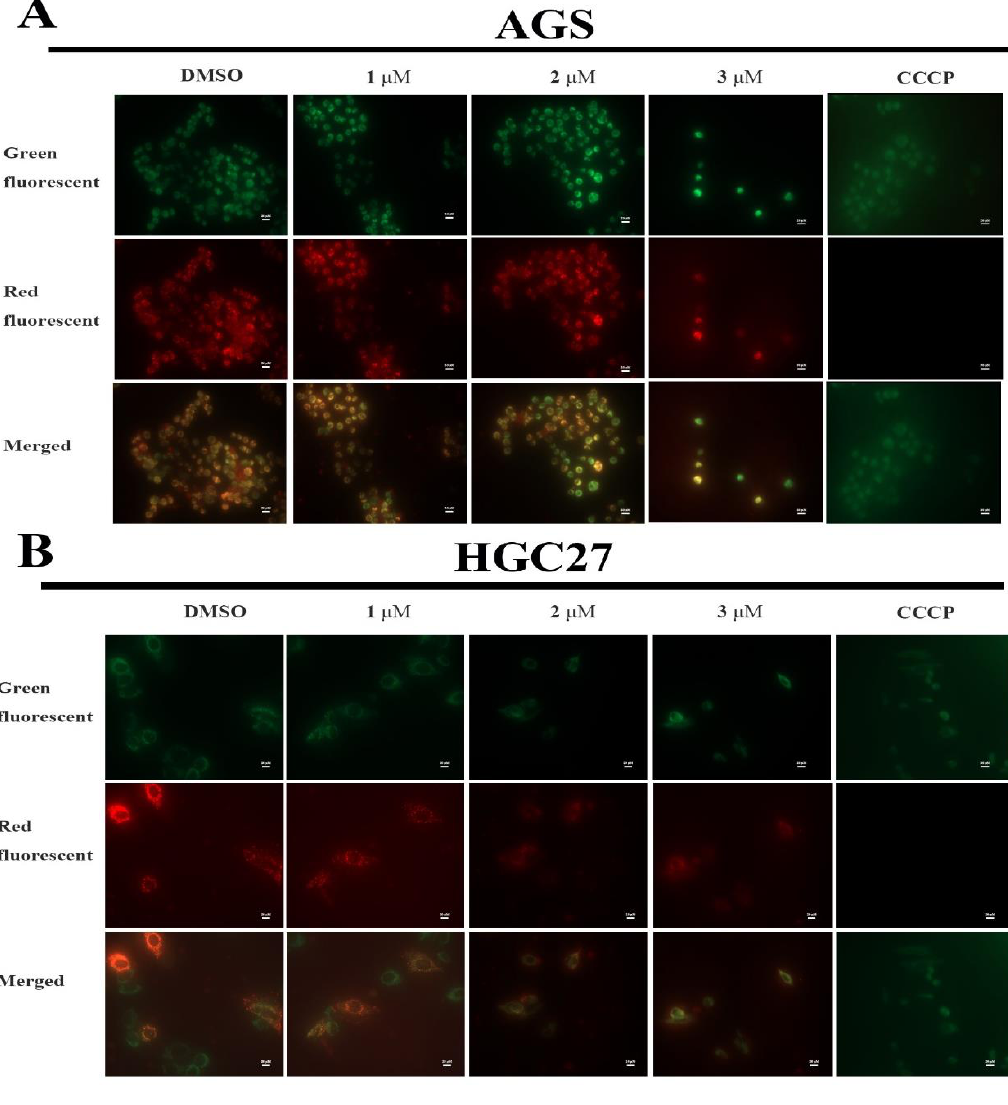
Figure 4. BLG26-induced mitochondrial depolarization in HGC27 and AGS cells. ( A , B ) Cells were treated with BLG26, CCCP (5.0 μM ), and DMSO for 48 h and mitochondrial membrane potential treated with BLG26, CCCP (5.0 µ M), and DMSO for 48 h and mitochondrial membrane potential was determined using the JC-10 kit. Scale bar 20 μM